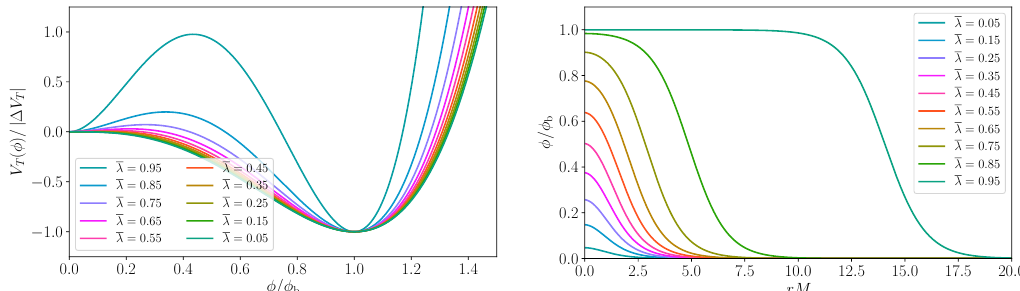
Figure 9: Left panel: the scaled quartic potential as a function of the parameter ¯ λ , defined in Eq. (6.18). Right panel: the critical bubble solution to Eq. (6.17). Scripts by kind permission of D. Cutting, see also Ref. [ 55 ]